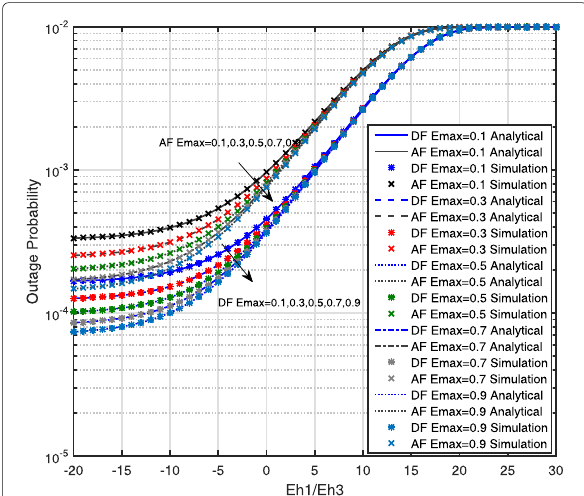
Fig. 3 Outage probability versus E h 1 for ρ with AF